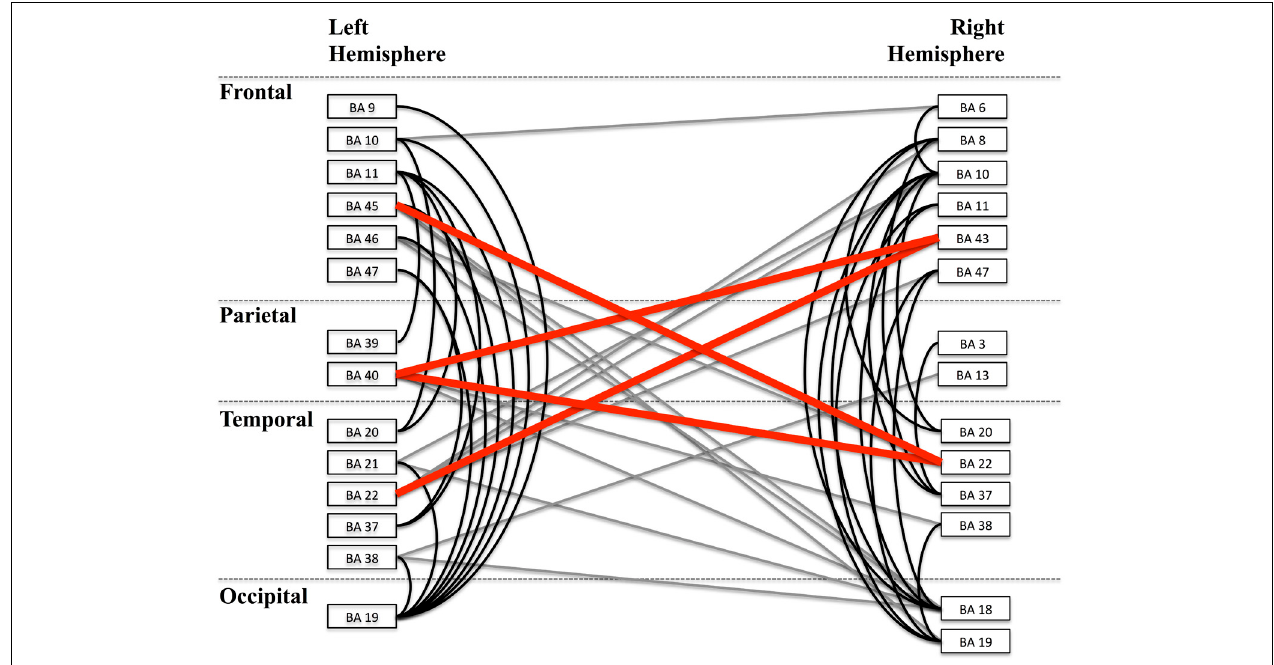
FIGURE 9 | Alpha band network. A depiction of the full alpha-band network is shown with each cluster labeled according to the nearest Brodmann area (BA) for visualization. Clusters are organized by lobe. Lines between regions indicate a significant connection between